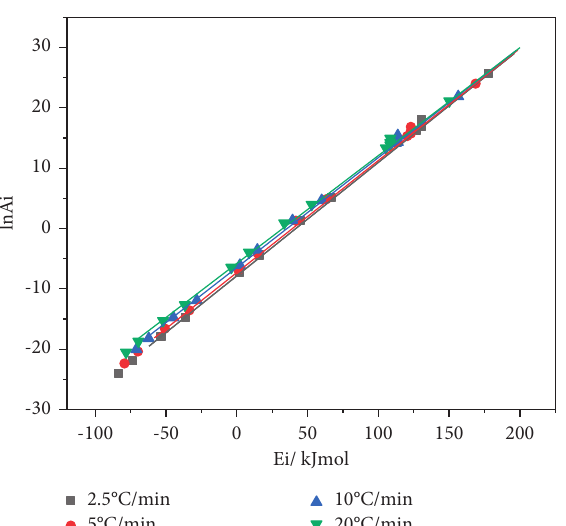
Figure 5: Observed compensation effect between the preexponential factor and apparent activation energy for thermal decomposition of the p-EGF:AA copolymer at different heating rates.